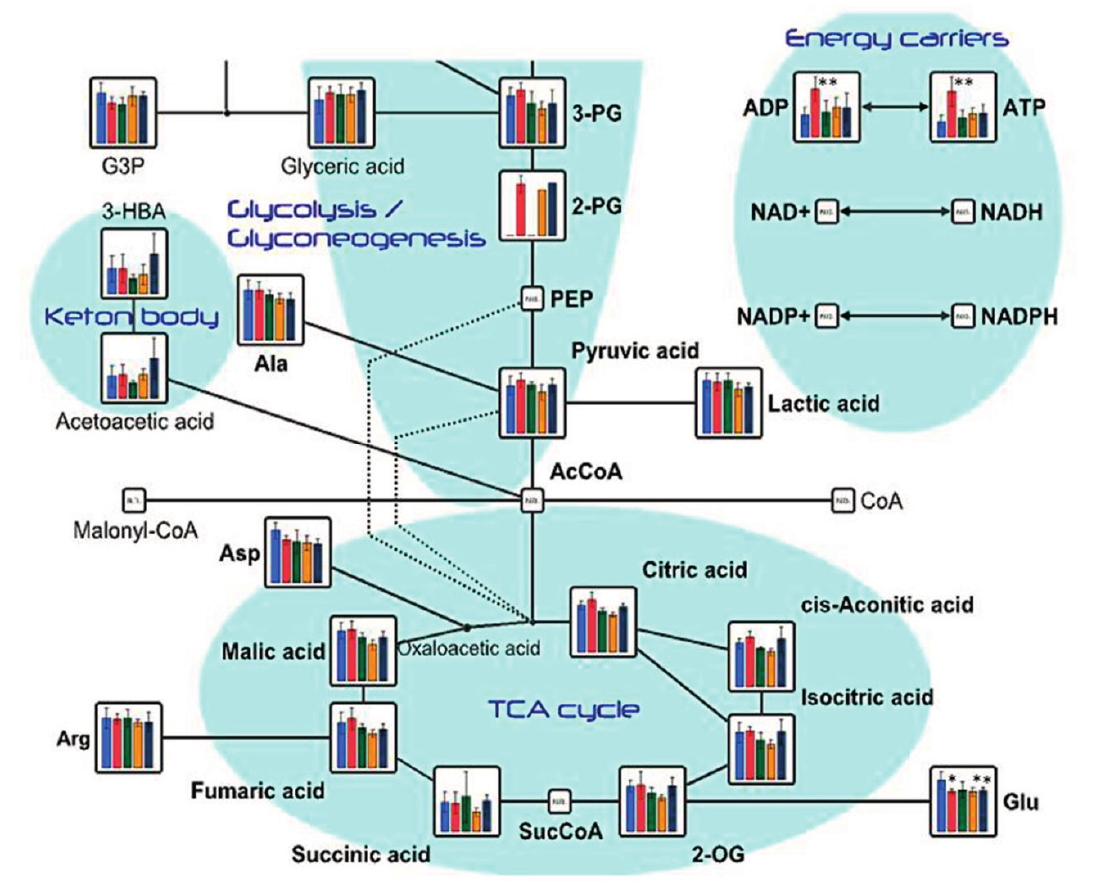
Figure 2. Levels of plasma metabolites related to tricarboxylic acid (TCA) cycle, nucleotides sugars, and pentose phosphate pathways. Each bar indicates median ± standard deviation (SD) of metabolite in each group. * p < 0.05, ** p < 0.01 indicate significant differences in metabolite concentrations compared to the control group. All the p -values were determined using Welch’s t -test. (blue, control; red, CNFs; green, SDACNFs; orange, chitin; navy, cellulose nanofiber (CLNF); G3P, D -glyceraldehyde 3-phosphate; 3-PG, 3-phosphoglycerate; 2-PG, 2-phosphoglycerate; ADP, adenosine diphosphate; ATP, adenosine triphosphate; 3-HBA, 3-hydroxybenzoate; PEP, phosphoenolpyruvate; NAD, nicotinamide adenine dinucleotide; NADP, nicotinamide adenine dinucleotide phosphate; NADPH, reduced nicotinamide adenine dinucleotide phosphate; Ala, alanine; Asp, aspartate; AcCoA, acetyl coenzyme A; Arg, arginine; SucCoA, succinyl coenzyme A; Glu, glucose; 2-OG,